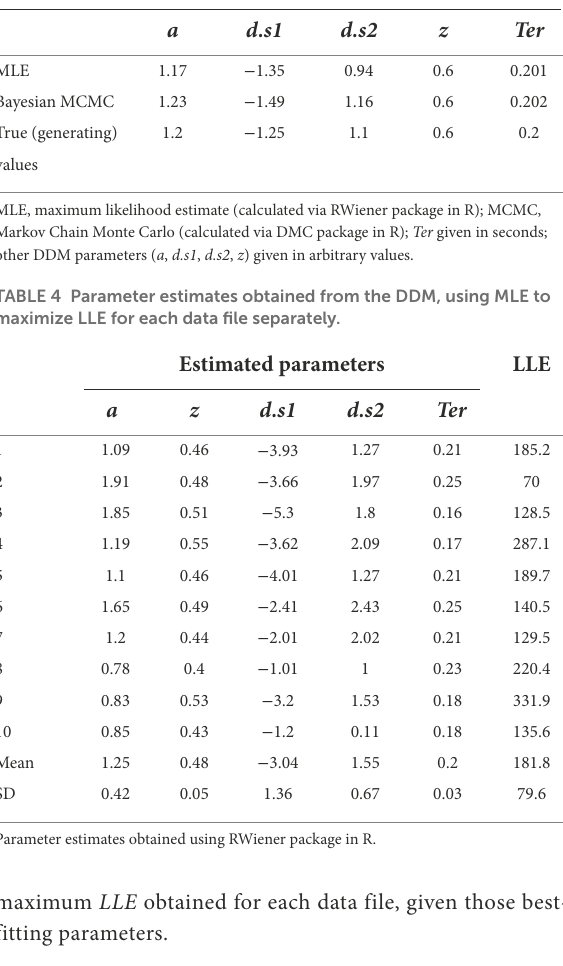
TABLE 3 Parameter estimates for DDM with five free parameters, applied to the dataset of Figure 1 , using MLE and Bayesian MCMC (means of posterior estimates are shown), and “true” generating parameters.